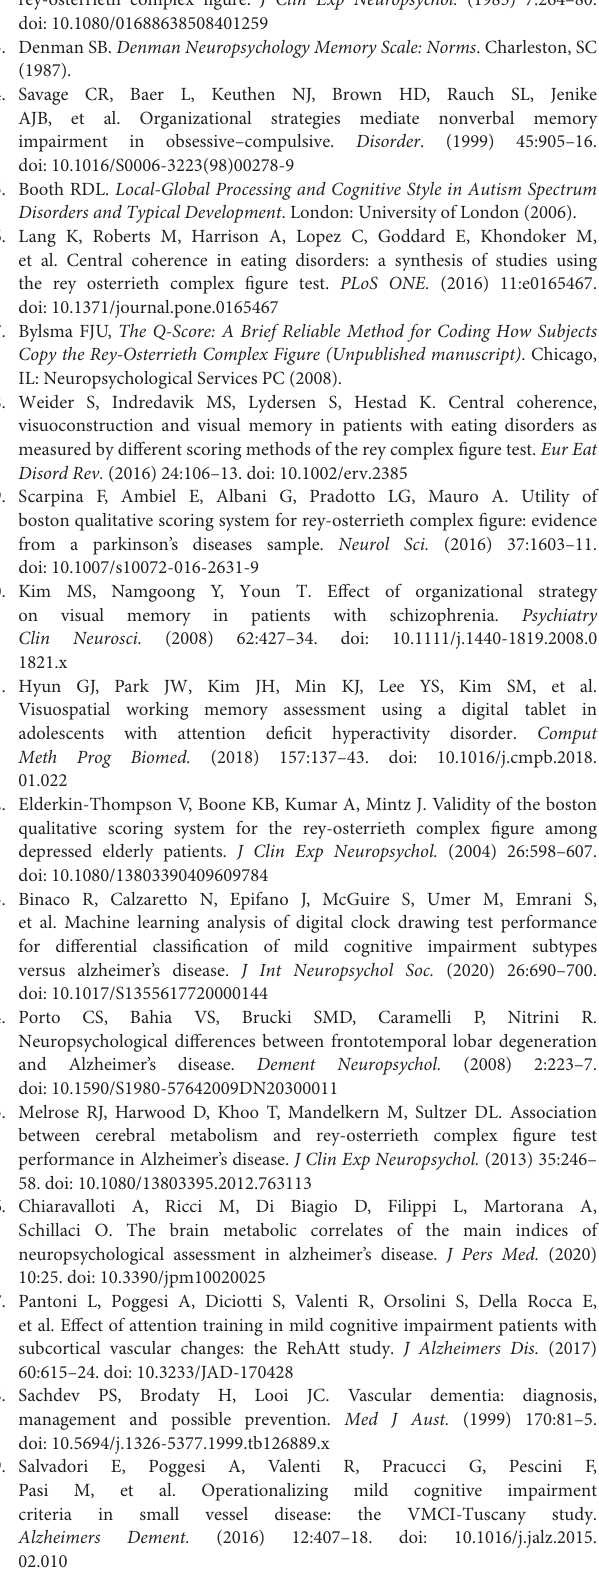
figure test: an analysis, and a new technique for single-case assessment. Bri J Clin Psychol. (1984) 23:109–19. doi: 10.1111/j.2044-8260.1984.tb00634.x 31. Somerville J, Tremont G, Stern RA. The boston qualitative scoring system as a measure of executive functioning in rey-osterrieth complex figure performance. J Clin Exp Neuropsychol. (2000) 22:613–21. doi: